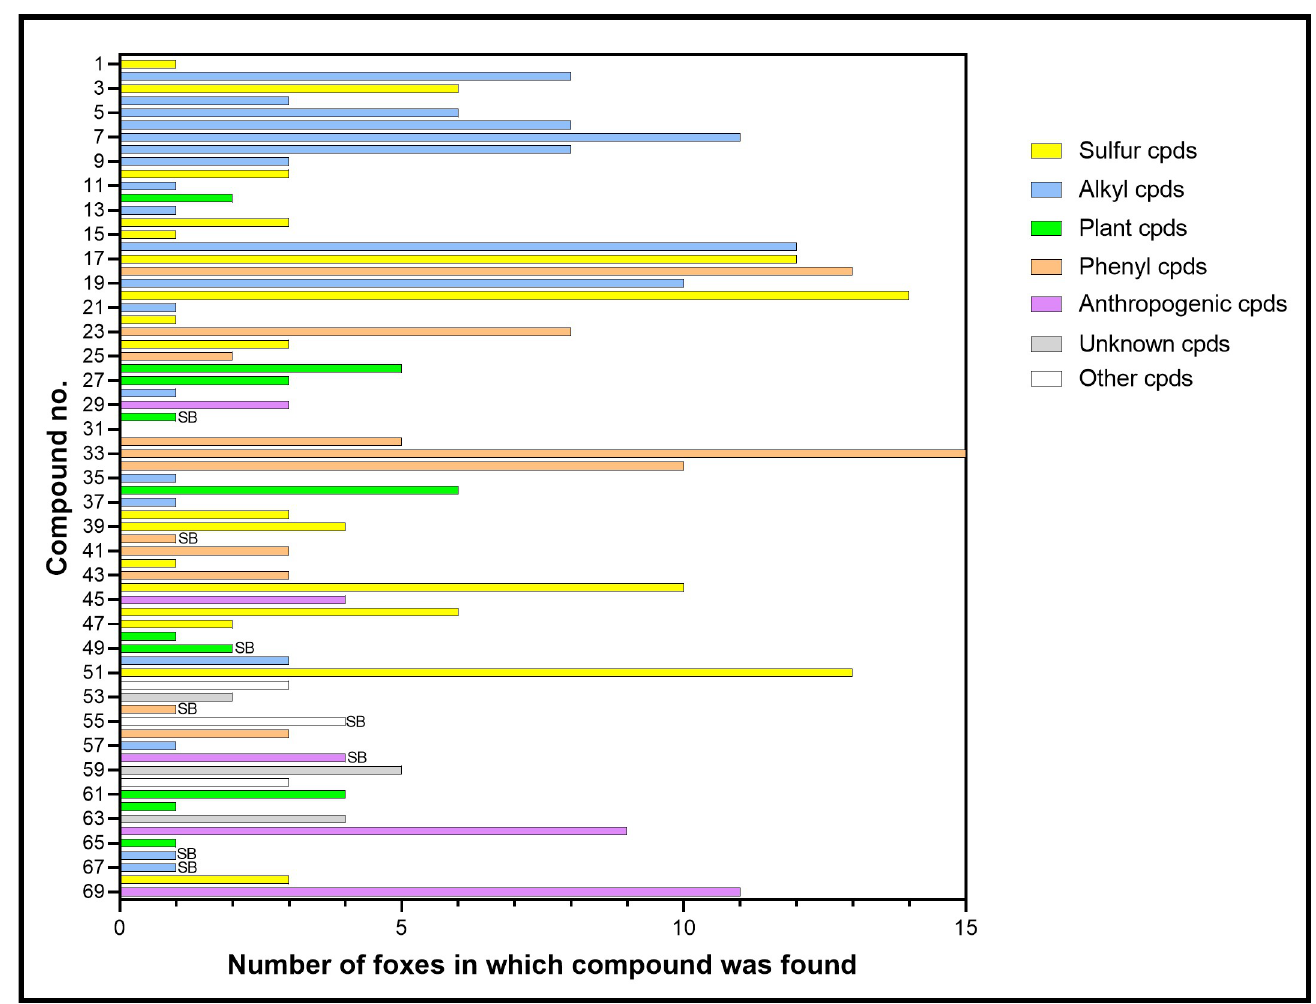
Fig 2. Number of foxes in which each compound was found. Only acetophenone (compound no. 33) was found in all 15 foxes. The internal standard (31) was only present when added, and 8 compounds were only found in stir bar (SB) analyses which were conducted on 4 samples. The colours indicate the chemical groups in Table